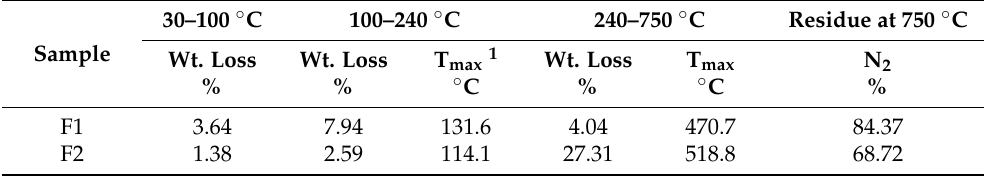
Figure 3. TGA curves of the fluorinated silica materials (as powdered materials): TEOS/MTES/FS (F1) and TEOS/MTES/HDTMES/FS (F2). Table 1. The maximum decomposition temperature (T max ) and weight loss (Wt. loss %) of the fluorinated silica materials, obtained as powdered materials (30 – 750 °C range).